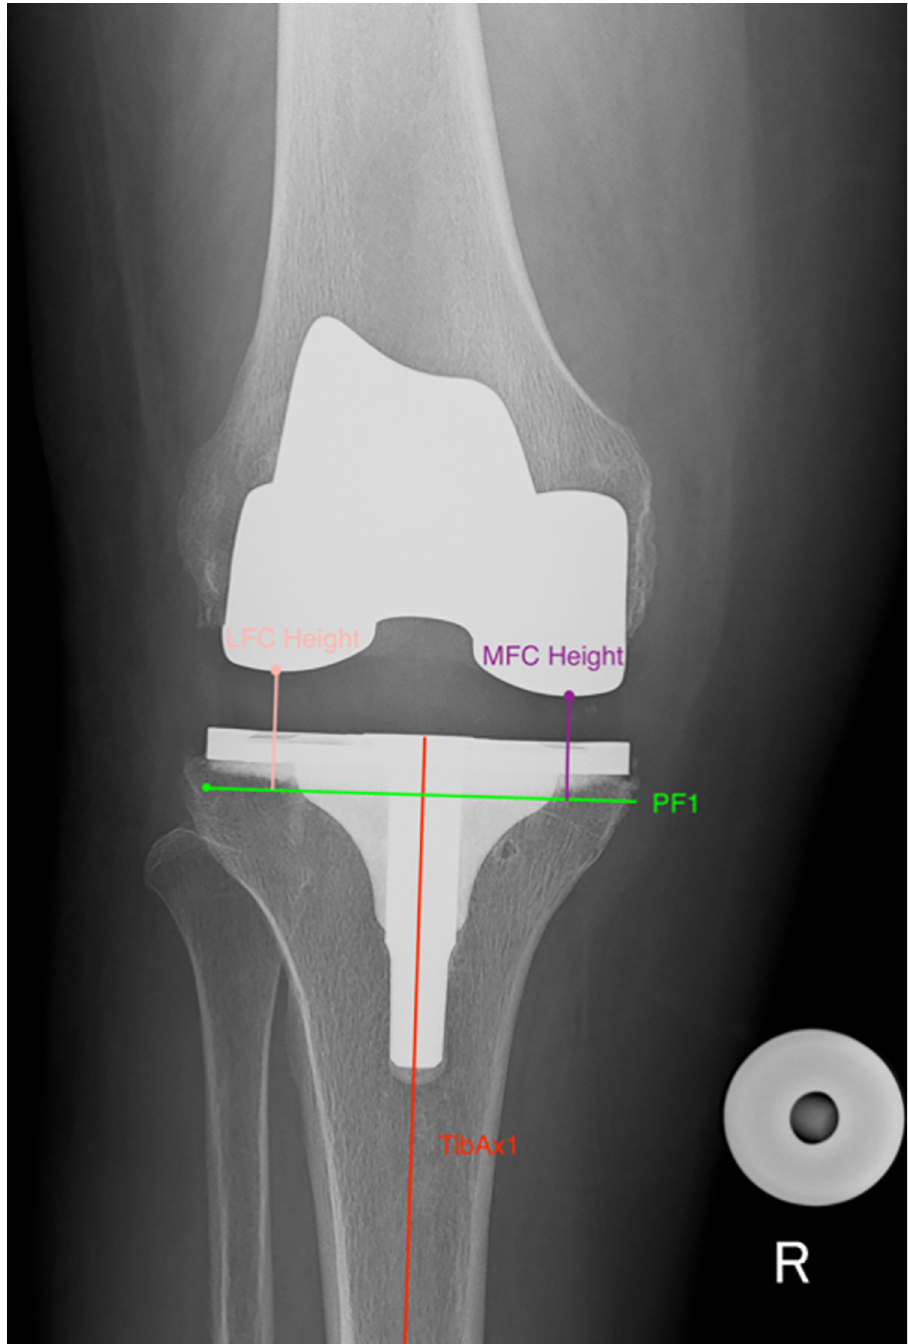
Fig 2. Post-operative IJLCM technique. Assessment of post-operative joint line height calculated as the average value of the Lateral Femoral Condyle (LFC) Height and the Medial Femoral Condyle (MFC)